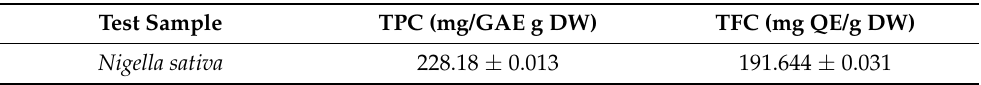
Table 1. Total phenolic and flavonoid content of Nigella sativa aqueous extract (NSAE). Data repre- sented as mean ± SD of triplicate tests. Test